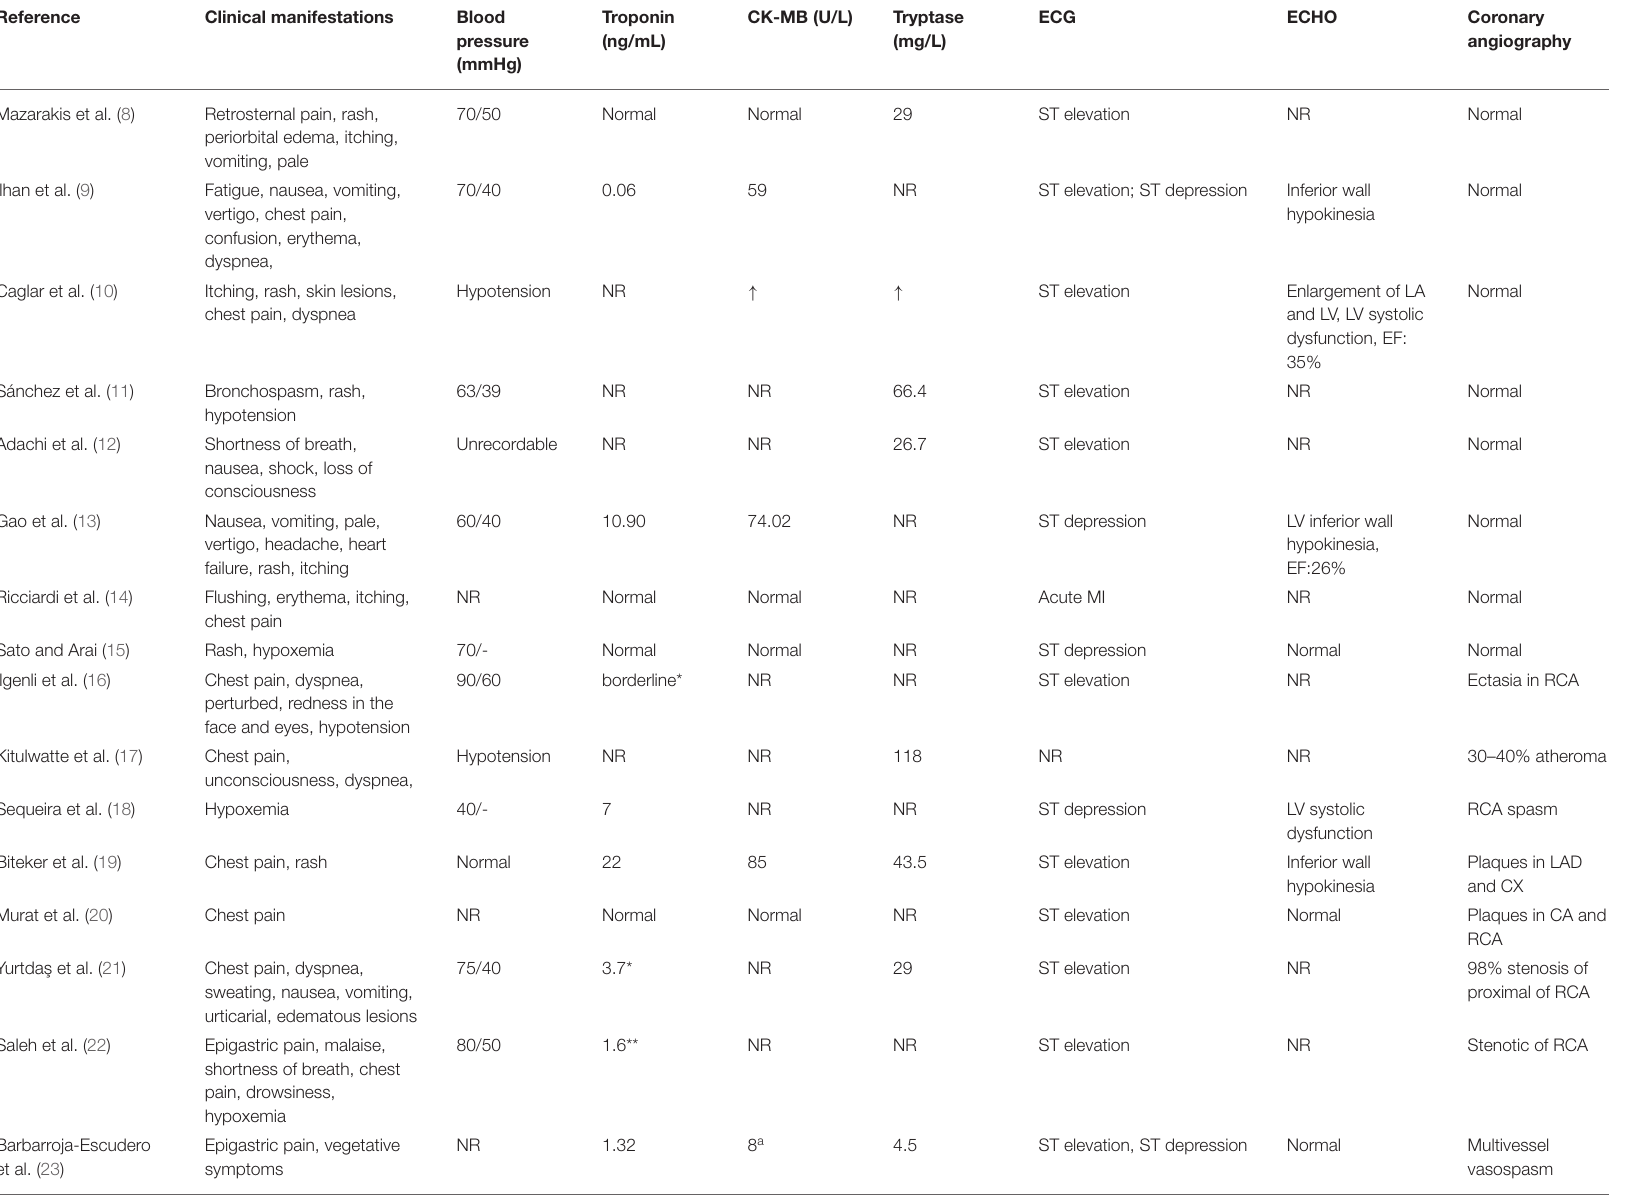
TABLE 2 | Clinical manifestations and laboratory and imaging examinations of the 25 included